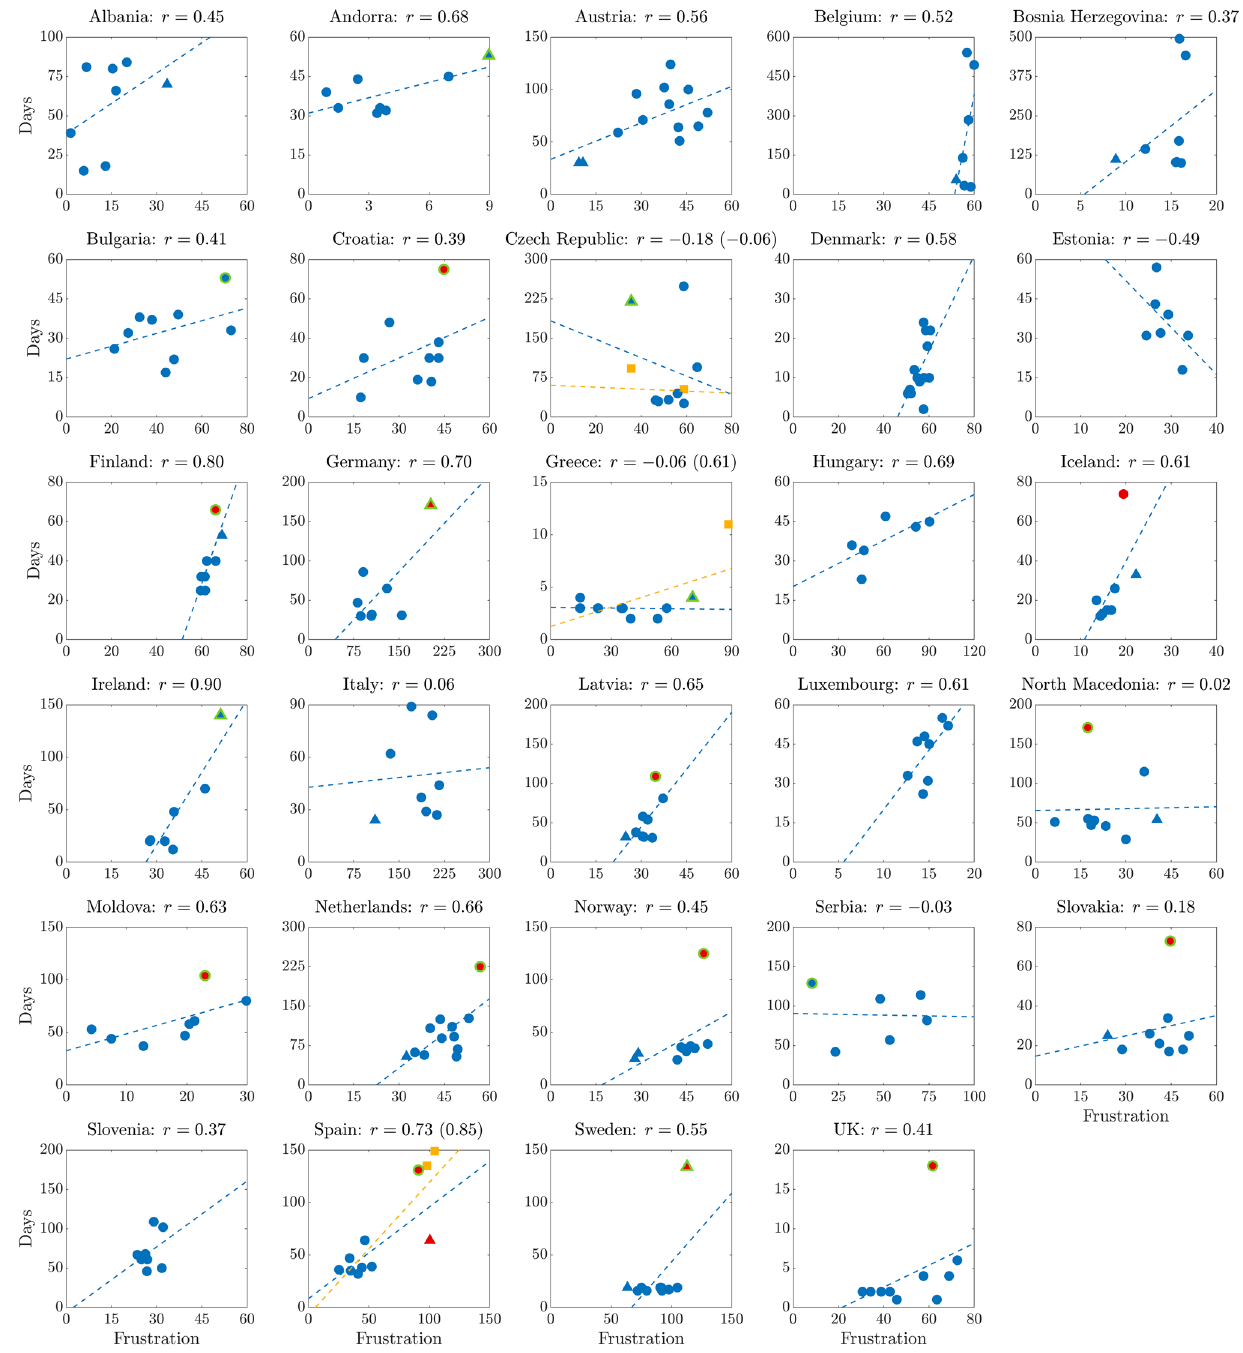
Figure 3. Scenario I . Frustration of the parliamentary networks v.s. duration of the government negotiation talks (days) and corresponding linear regression line, for all countries of Table 1. The value of Pearson correlation ( r ) for each country is reported in the plot heading. Legend: blue circles represent points that are neither outliers, nor high leverage nor influential. A red symbol indicates an outlier, a triangle a high leverage point and a symbol with green outline an influential point. Residual analysis, leverage statistic and delete-1 statistics are used to identify outliers, high leverage and influential points, respectively. Yellow square data points indicate elections corresponding to failure of government negotiations resulting in votes of no-confidence (Czech Republic in 2006 and 2017) and new elections (Spain in December 2015 and April 2019, Greece in May 2012). Blue regression lines include only the successful government formations. Including also the failure points we obtain the yellow regression lines. In all three cases, the correlation increases (values are reported between